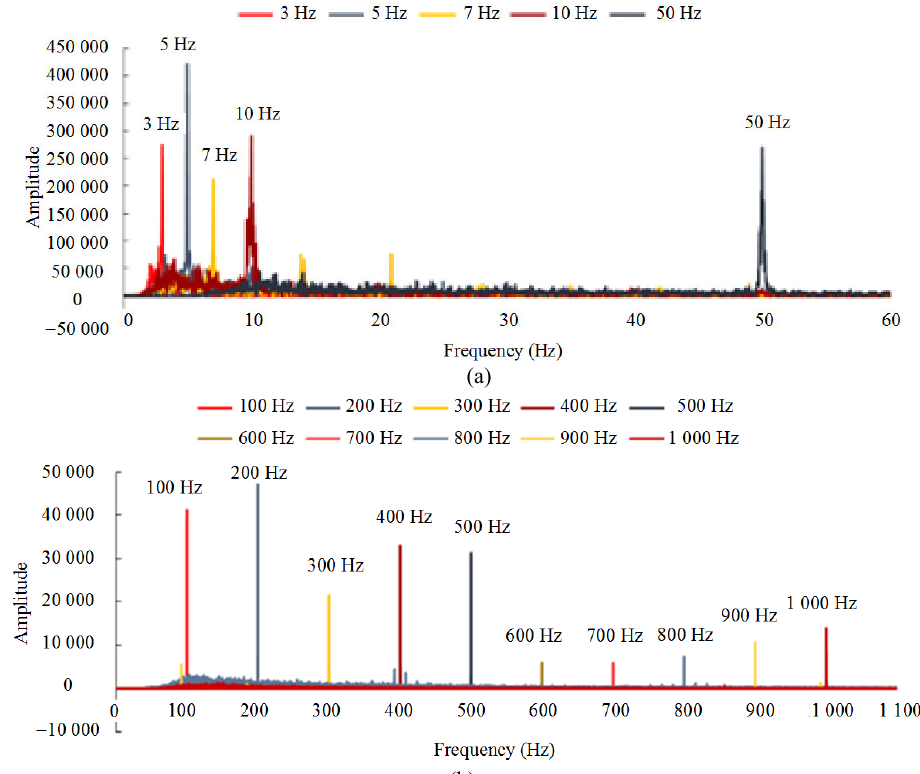
Fig. 8 Spectrum of the demodulated signal at different frequencies when the voltage of the sinusoidal driving is 5V: (a) the spectrum of demodulated signal at the low frequencies and (b) the spectrum of demodulated signal at the high frequencies.